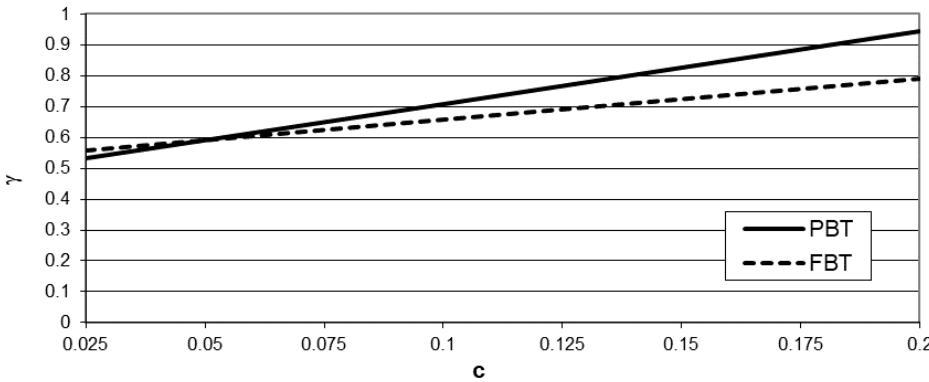
Figure 13. Dependence of γ on c for both agitators.